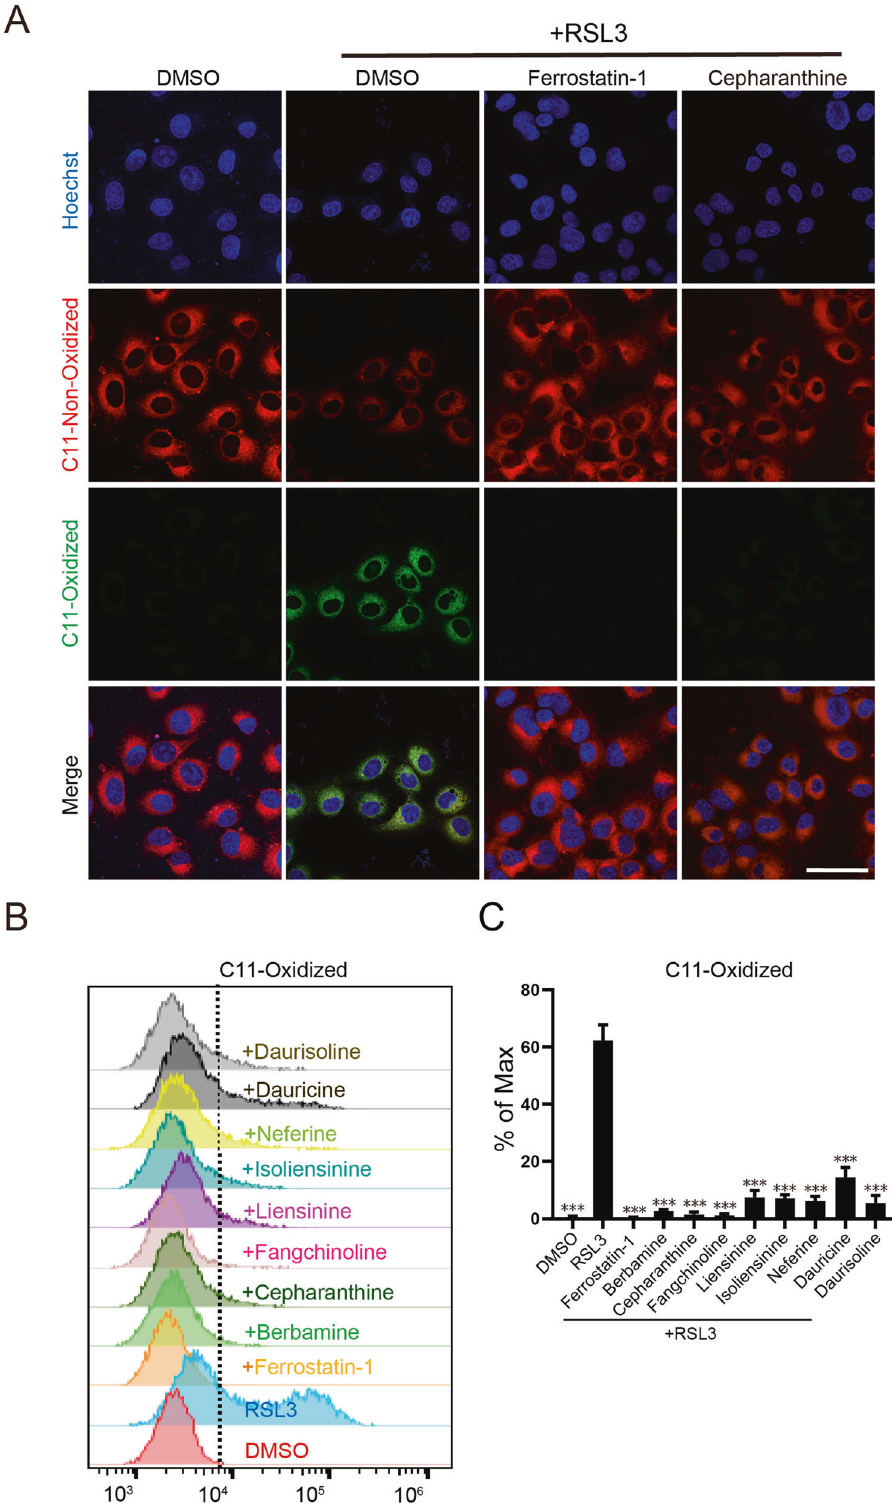
Fig. 3 Analysis of RSL3-induced lipid ROS by C11-BODIPY 581/591 staining. A Representative images of immuno fl uorescence staining of lipid ROS. Cells were treated as described in Fig. 2A then stained with the C11 BODIPY 581/591 probe (2 μ M for 20 min) and analyzed by confocal imaging. Scale bar: 50 μ m. B Flow cytometry analysis of RSL3-induced oxidation of C11-BODIPY. C Statistical results for ( B ). Data represent mean ± s.d. from three independent repeats. p value (vs. RSL3 alone) is determined by ordinary one-way ANOVA with Dunnett ’ s multiple comparisons test. ***, p <